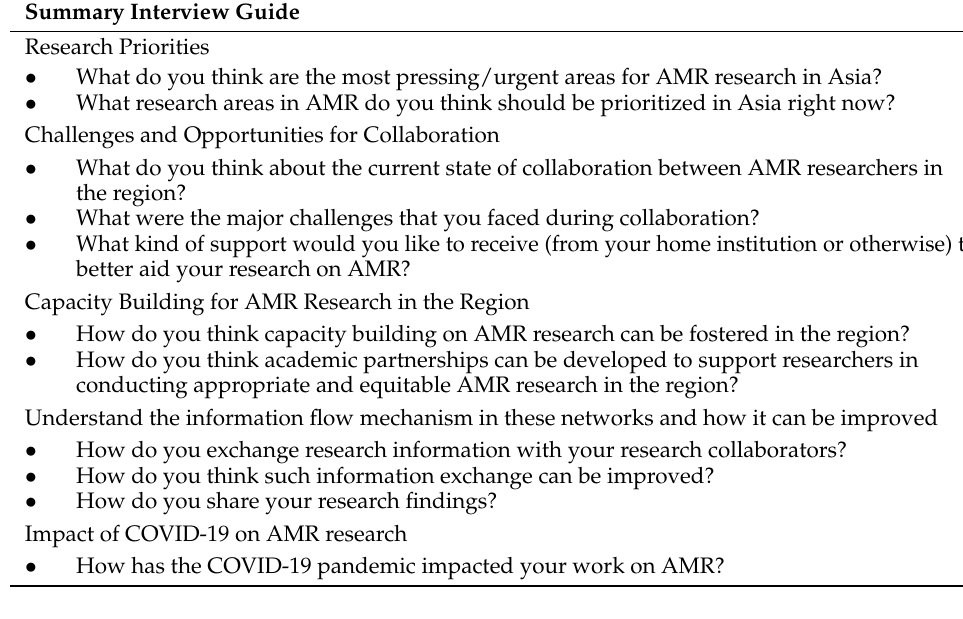
Table 1. Summary of the interview guide. Summary Interview